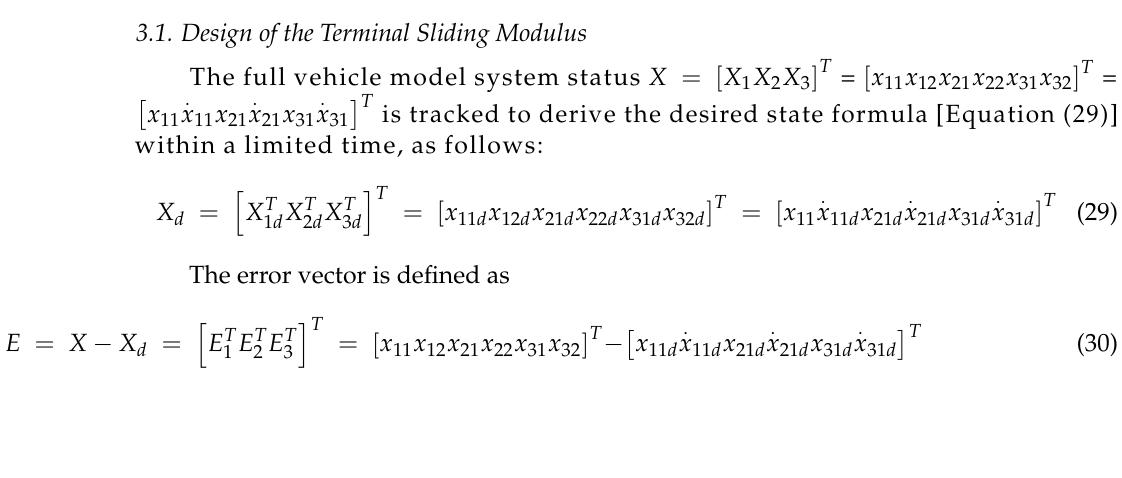
Figure 3. Controller design block diagram.